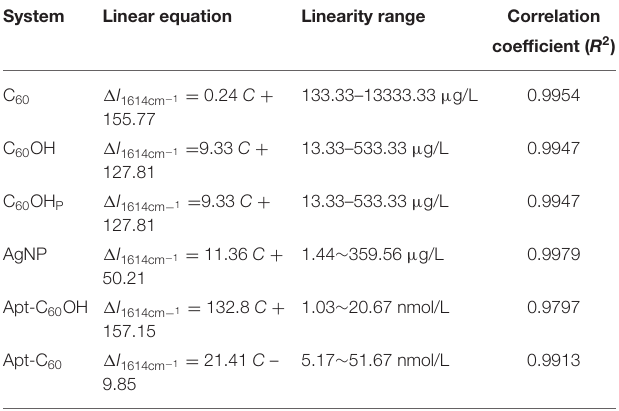
TABLE 1 | The catalytic effect of various catalyst and the inhibiting effect of Apt. System Linear equation Linearity range Correlation